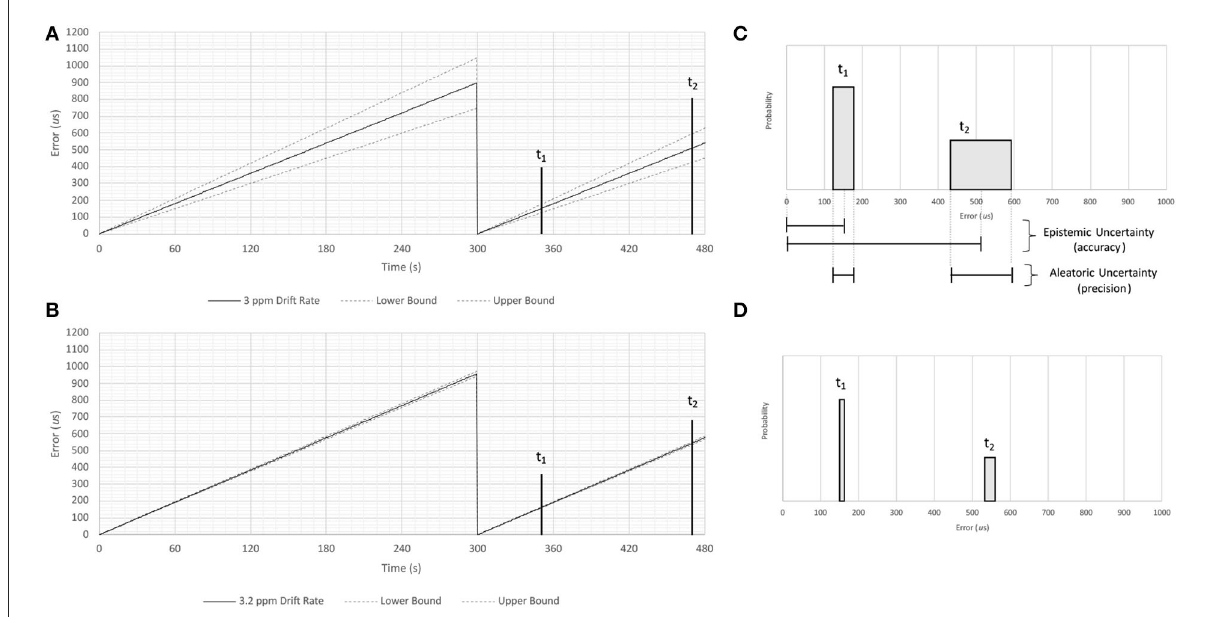
FIGURE4 Conceptual illustration of epistemic and aleatoric uncertainties resulting from clock drift. This figure illustrates concepts discussed in the literature cited in Sections 2.2 and 7.1. A series of measurements of time are made using a hypothetical clock that is synchronized with a more accurate timepiece once every 300 seconds. Panel (A) shows timing errors caused by a drift rate measured to one significant figure (3 ppm), while panel (B) shows timing errors caused by a drift rate measured to two significant figures (3.2 ppm). Shaded regions in Panels (C,D) show the accuracy and precision of temporal measurements assuming these two drift rates 50 and 170 s after synchronization (labeled t 1 and t 2 , respectively). Note that imprecisely specified drift rates result in aleatoric uncertainties that increase as a function of time, and that the magnitude of the uncertainty is inversely proportional to the number of significant figures used to specify the drift